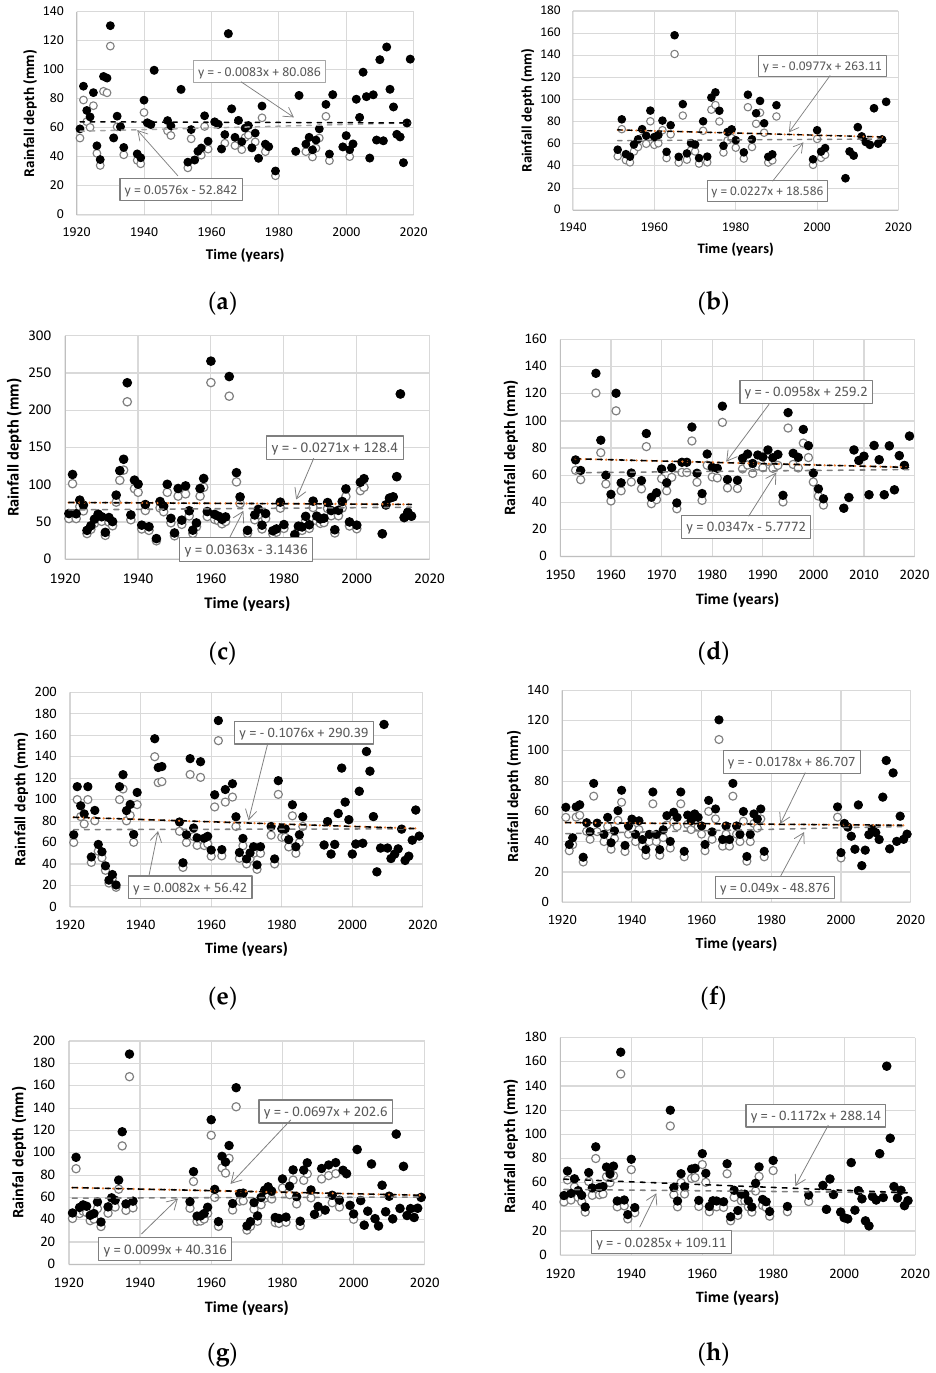
Figure 3. Time sequence of “uncorrected” and “corrected” annual maximum rainfall depths for duration 24 h, H d= 24 h , with the respective linear trends, for the following stations: ( a ) Umbertide; ( b ) Calvi dell’Umbria; ( c ) Ficulle; ( d ) Monteleone di Spoleto; ( e ) Narni Scalo; ( f ) Norcia; ( g ) Ponte Nuovo; and ( h ) San Savino. Available data within the period 1921–2019.